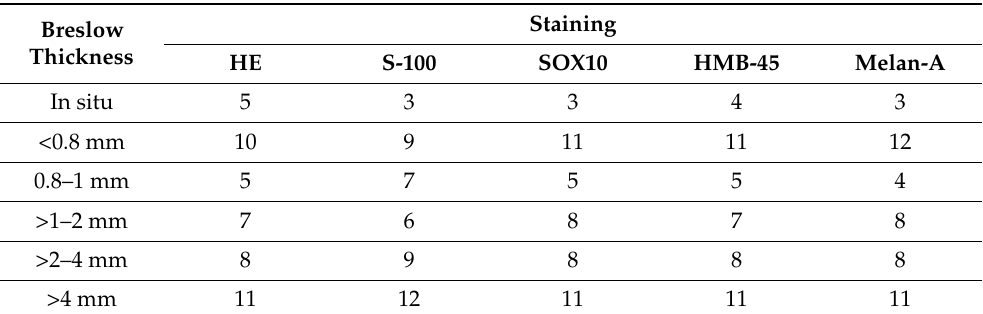
Table 2. The values of the Breslow thickness recorded on HE and IHC markers summarized according